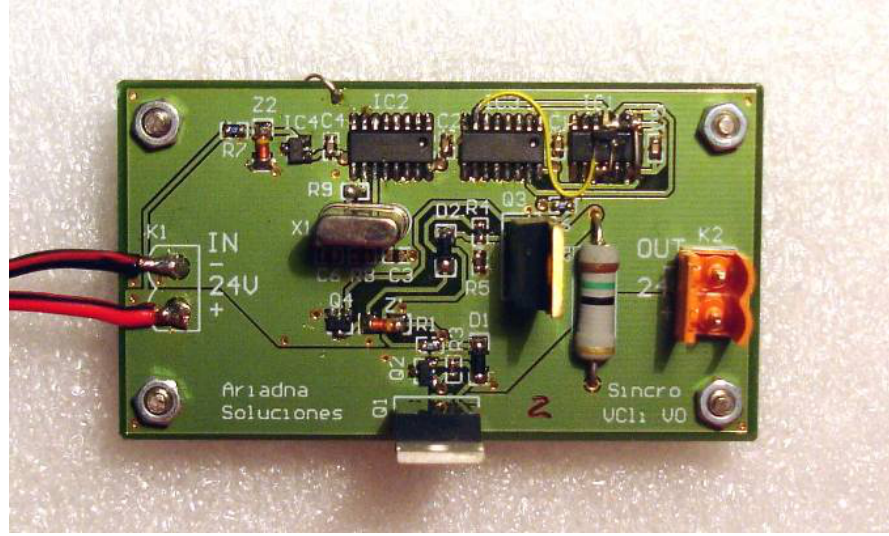
Figure 6 . Clock Generation PCB